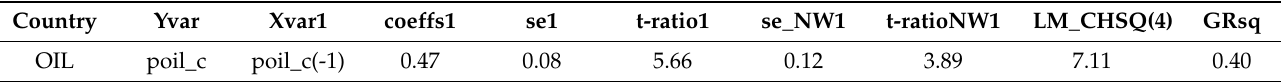
Table A7. Oil model-DSGE-GVAR.